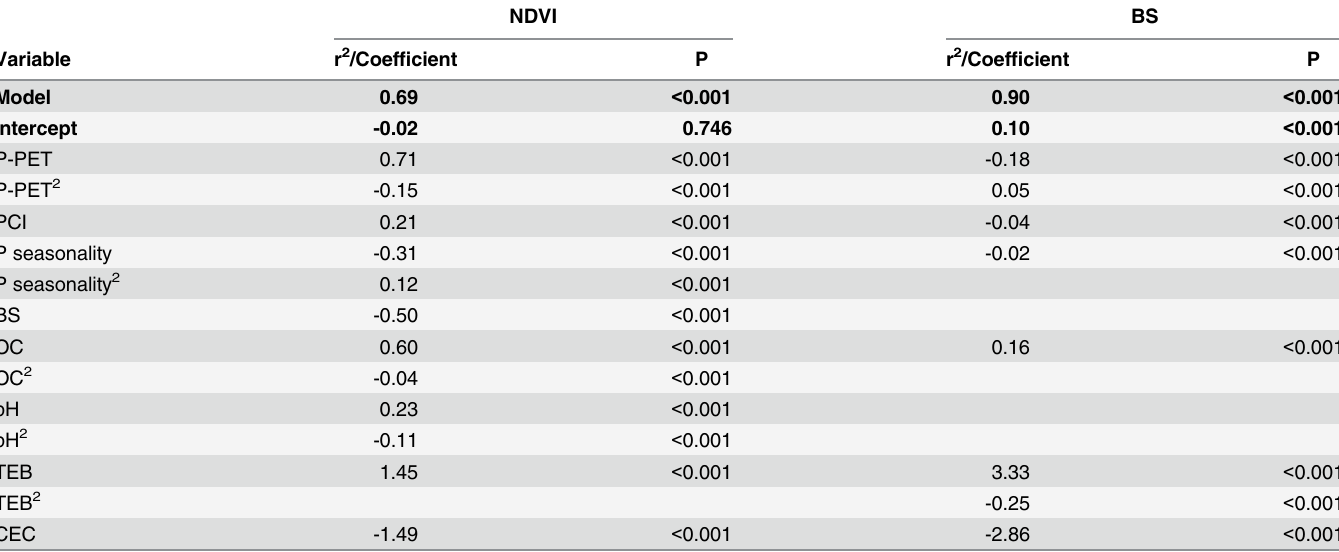
The standardized coef fi cients for each variable are shown with their P for inclusion in the model. The r 2 and P for the overall models and intercepts are also included (bold).